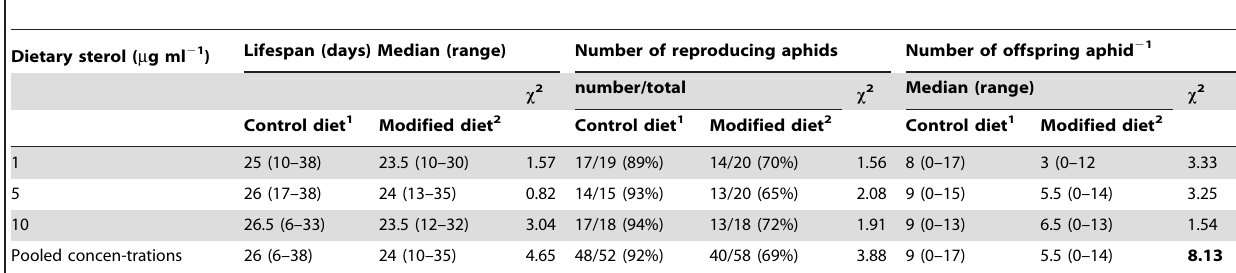
Table 3. Aphid performance on diets containing sterol profiles that mimic the phloem sap of control tobacco, and modified tobacco.